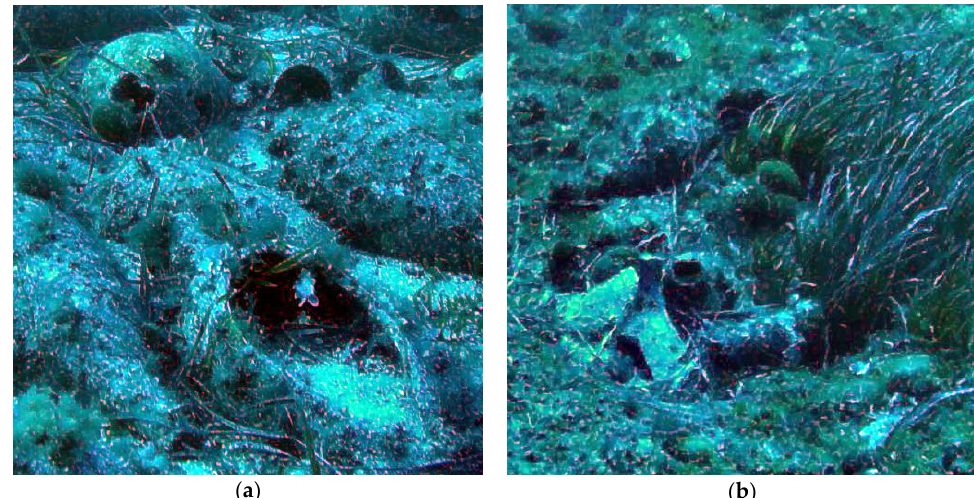
Figure 3. Artefacts in the sample images “CalaMinnola1” ( a ) and “CalaMinnola2” ( b ) enhanced with SP algorithm. SP